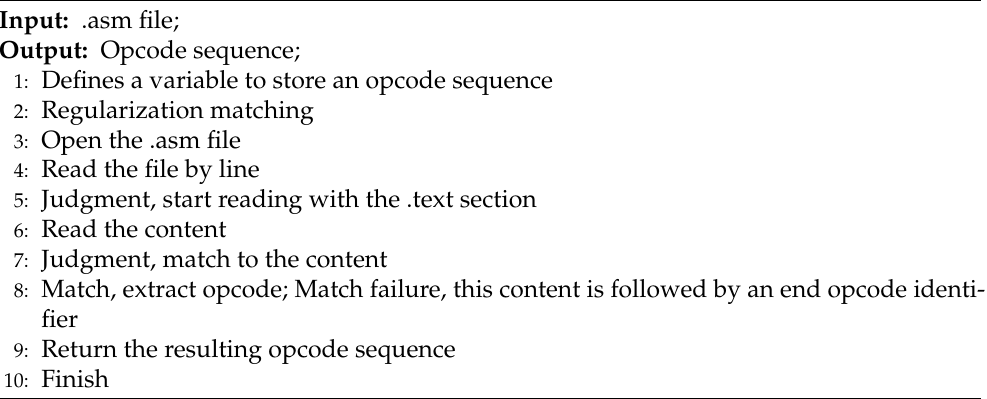
Algorithm 1 Extraction algorithm of opcode